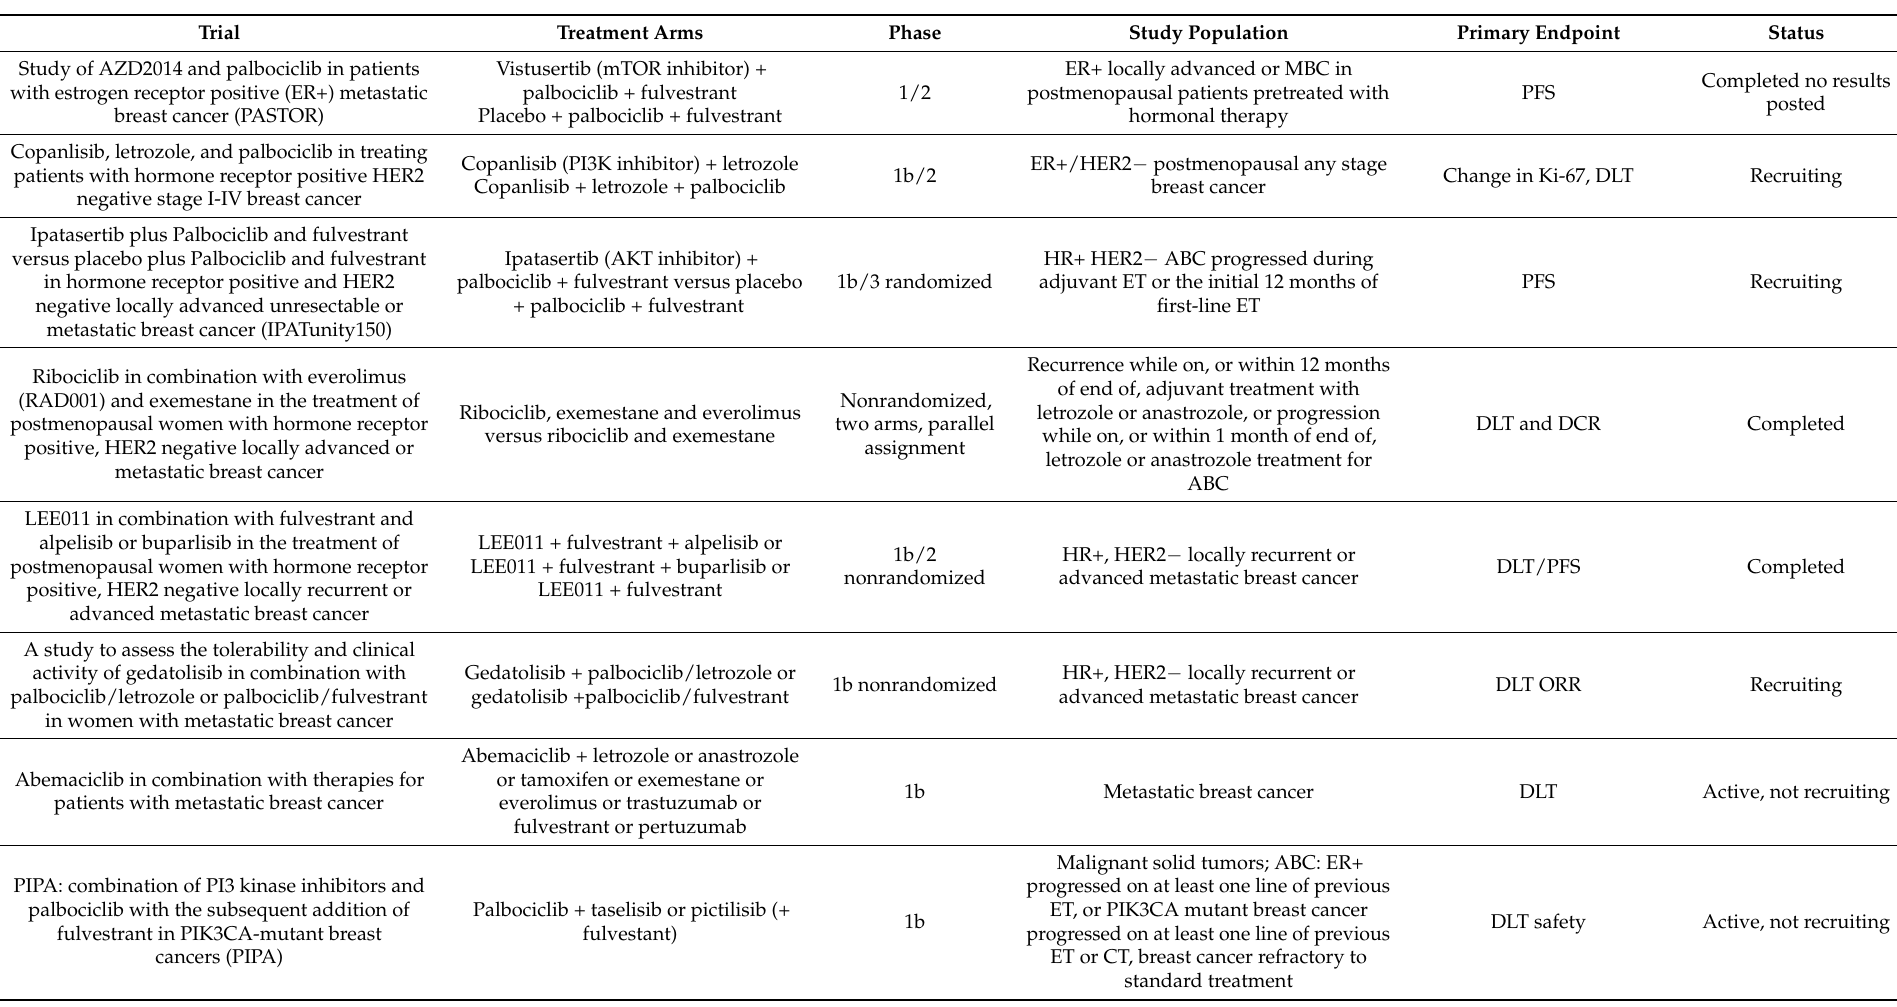
Table 5. Ongoing studies of multiple combination treatments with CDK4/6